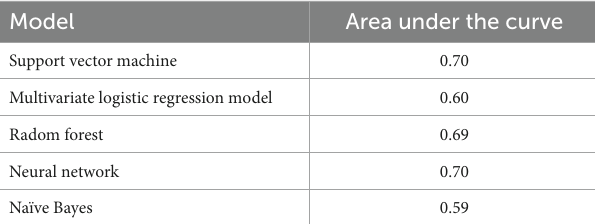
TABLE 2 The accuracy and AUC of machine learning